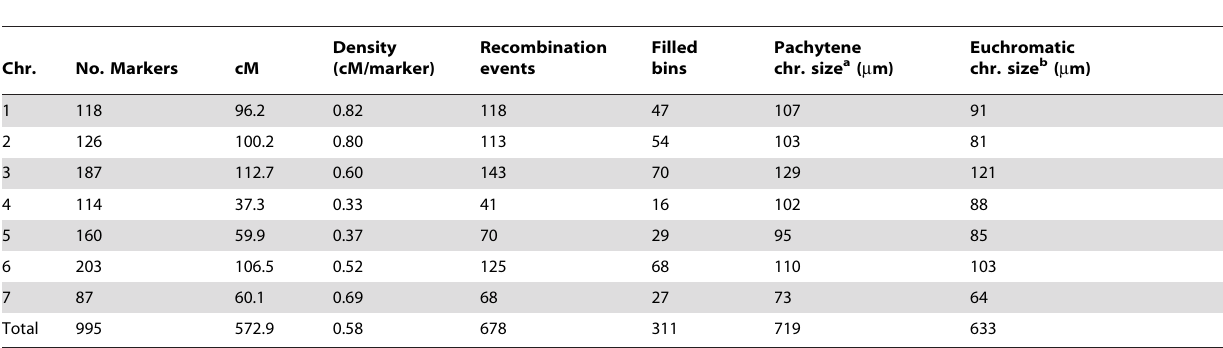
Table 1. Summary of the cucumber genetic map with RIL mapping population from the inter-subspecific cross between Gy14 and PI 183967.